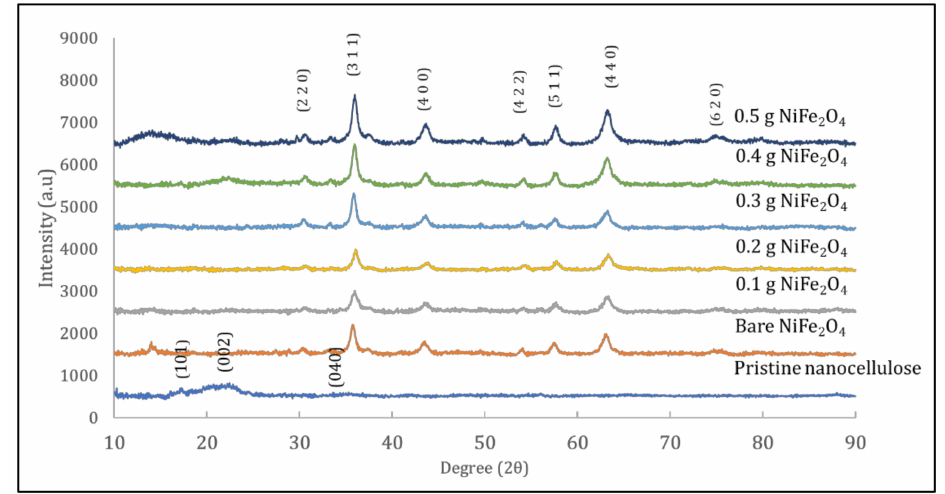
Figure 5. XRD pattern of pristine nanocellulose, bare NiFe 2 O 4 , and hybrid